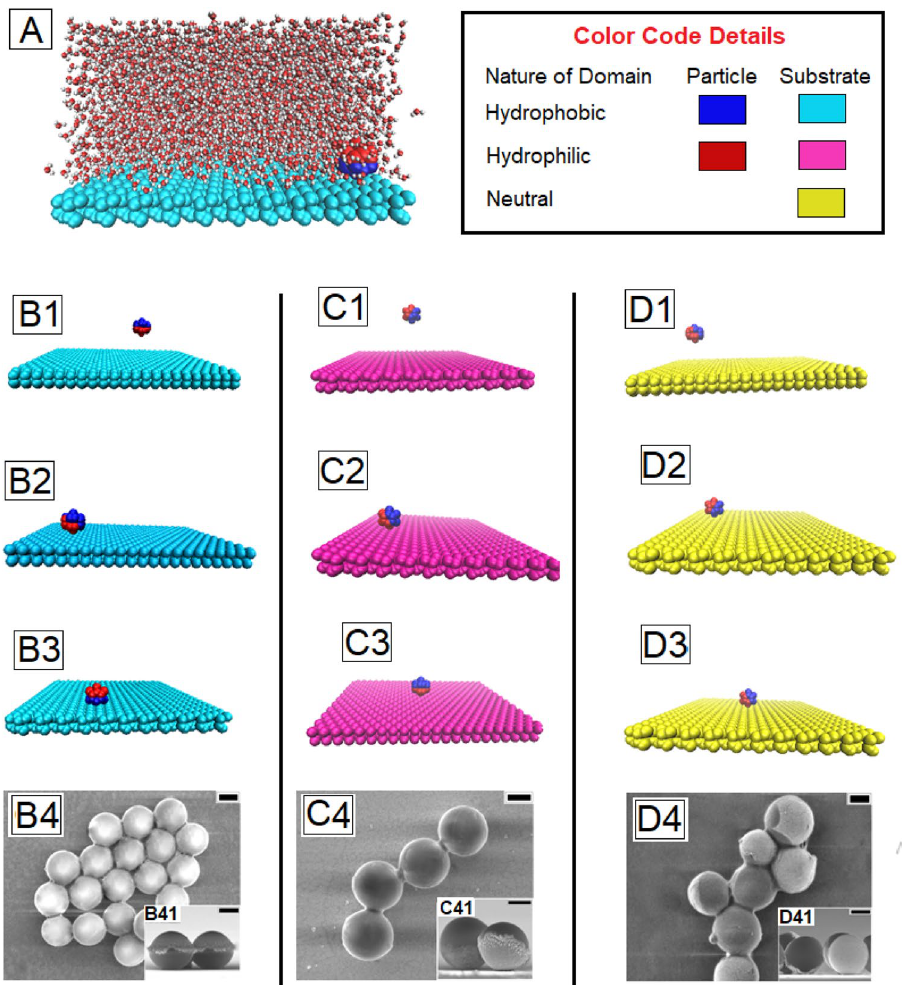
Figure 1. ( A ) S napshot of the system studied, comprising Janus particles in a semi infinite pool of water over a substrate or wall. The wettability is represented by the color coding for ease of viewing. ( B – D ) Simulation snapshots of the evolution of orientation of a single Janus particle as it approaches a non-wettable, a wettable, and a neutral substrate respectively, starting from an initial random orientation. To facilitate visualization, the water molecules are made invisible. The three frames in each column correspond to the snaps taken at 0 ns, 50 ns and 180 ns of the simulation run respectively. The third snapshot in each column ( B3 , C3 and D3 ) refers to the orientation of the particles after it has reached the substrate. The last images in each column ( B4 , C4 and D4 ) are FESEM images of the actual particles deposits after the solvent has fully evaporated away. The insets to these frames show the cross-sectional image to depict the orientation of the particles. The scale bar in each frame is 300 nm.